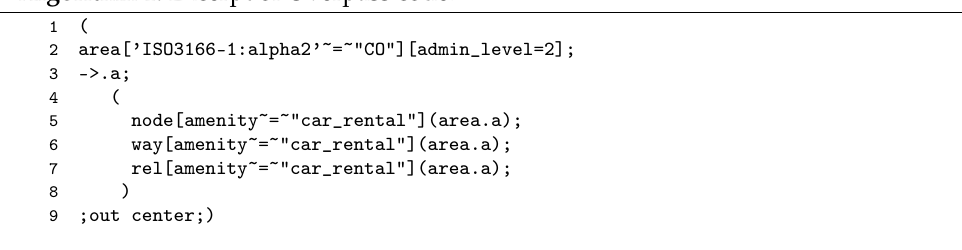
Algorithm 1: Excerpt of Overpass